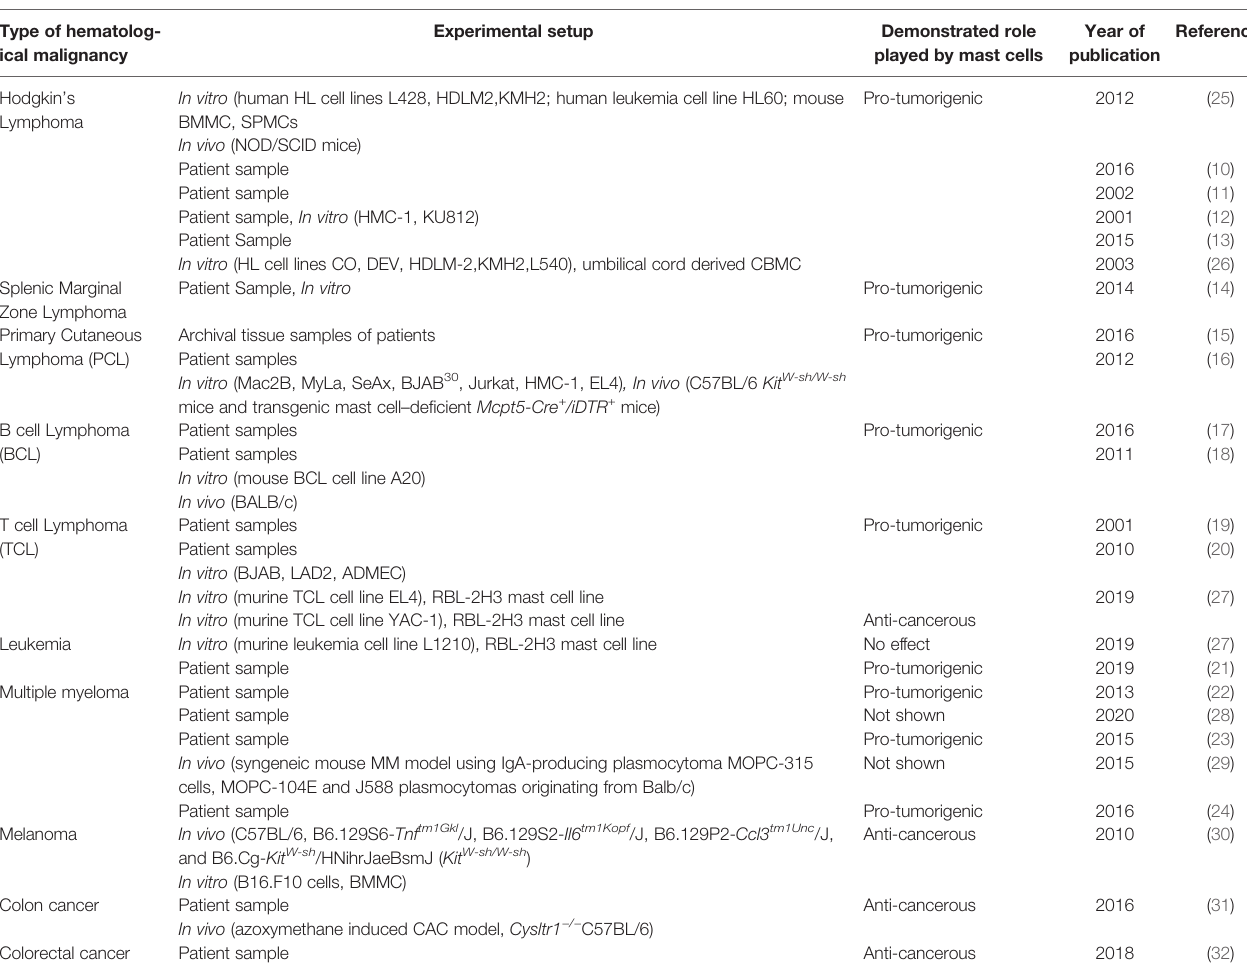
TABLE 2 | Experimental setup of the studies included in this review.